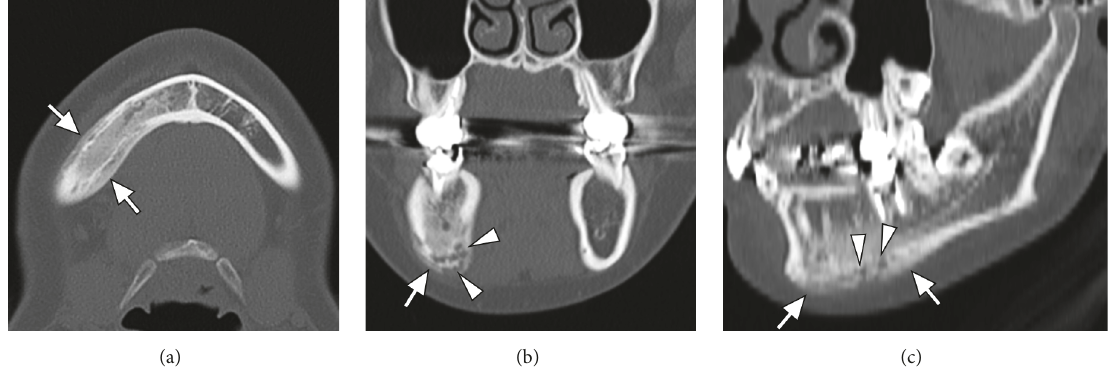
Figure 2: CT scan of the mandible. Axial (a) and coronal (b) and oblique sagittal reconstruction (c) plain CT images show sclerotic change and periosteal reaction in the right body of the mandible (arrows). Spotted osteolysis is also seen mainly in the cortical bone (arrowheads).